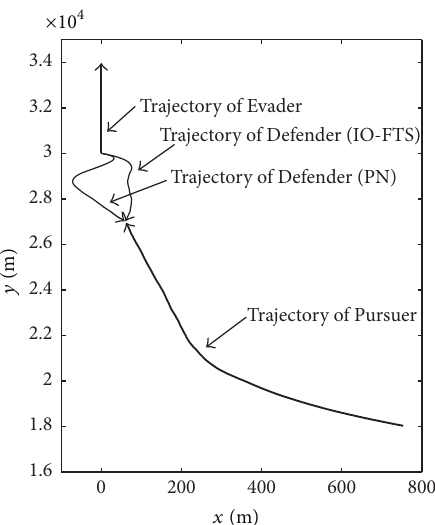
Figure 2: The trajectories while the Defender adopts PN or IO-FTS guidance law.